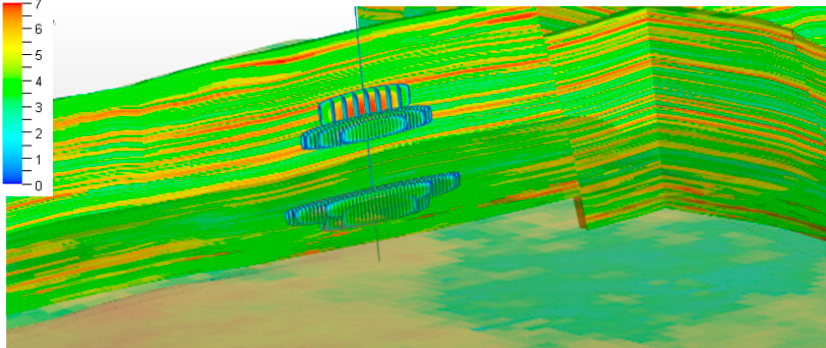
Figure 11. History matching curves of the liquid rate and oil rate.